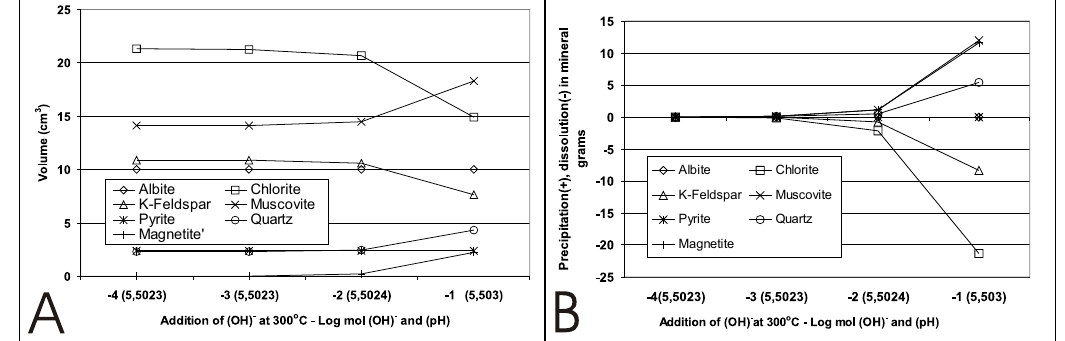
Fig. 6 – A – Variation in the volume of minerals of the paragenesis reacting with thefluid by the addition of (OH) − at 300 ◦ C (alkalization). B – Same results as in (A), yet expressed as variations in the precipitated (+) or dissolved (–) concentrations, in grams of minerals.